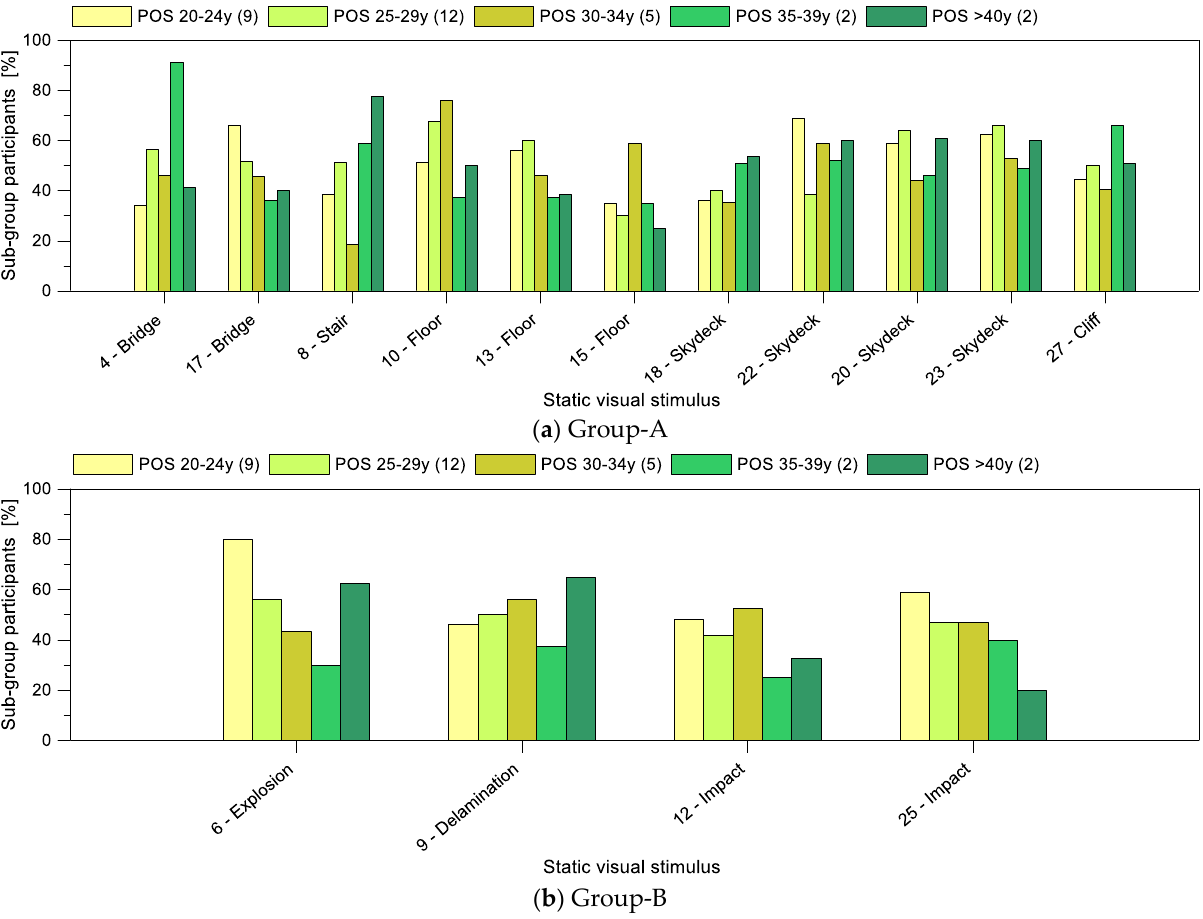
Figure 18. Detection of prevailing POS reactions (in percentage terms for participants), as a function of static stimulus, for ( a ) Group-A or ( b ) Group-B items. In evidence: the response for demographic sub-groups of volunteers.